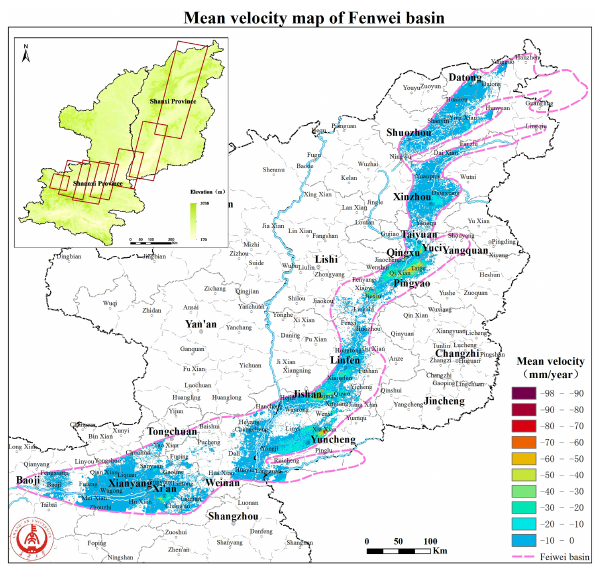
Figure 2. Annual land subsidence rate map in entire Fenwei basin.